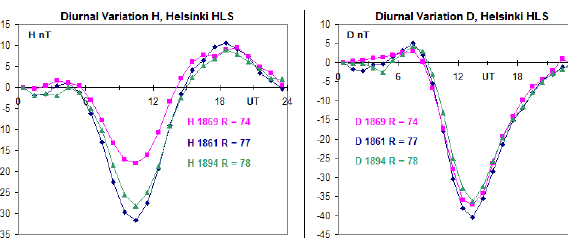
Figure A4. Diurnal variation of H (left) and of D (right) at Helsinki for 3 years with a SIDC sunspot number of ∼ 75. It is very hard to escape the conclusion that the range of H for the year 1869 is too small compared to the other years with a similar sunspot number as the range of D is about the same for the 3 years shown. The timing from 1882 on has been adjusted to 1h later (also in the following figure) because of a change from Göttingen time to local Helsinki time, which is not reflected correctly in the published data.